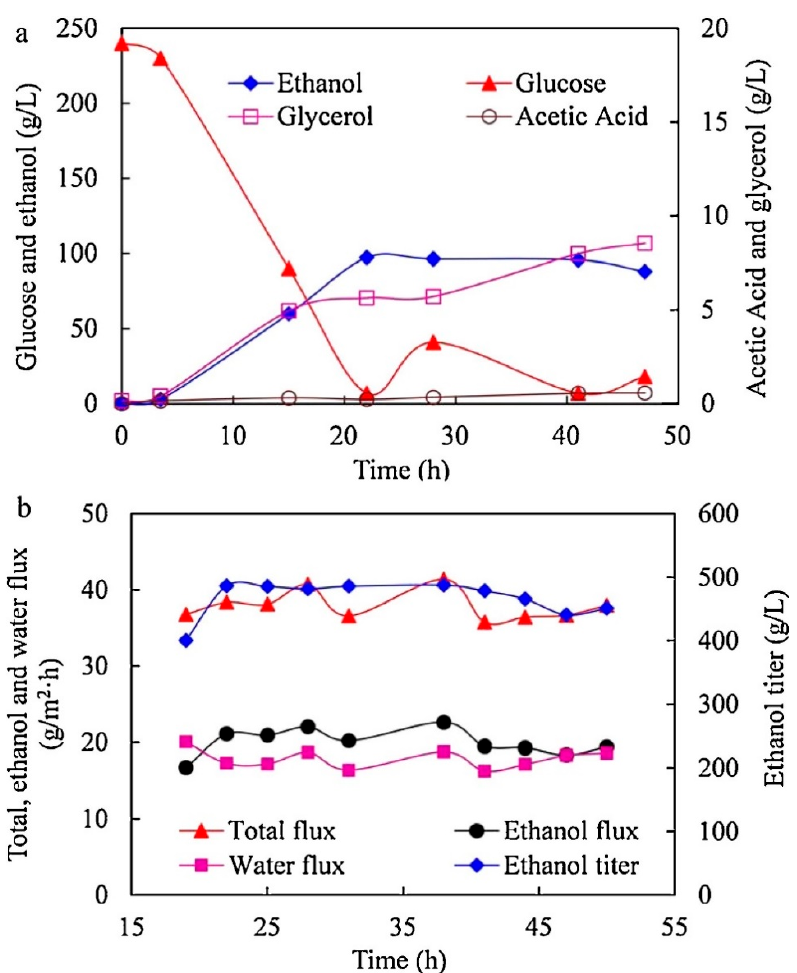
Figure 11. Ethanol fermentation based on pervaporation with a CNT-mixed PDMS membrane. ( a ) the rate at which the concentration of glucose and other products in the fermentation broth changes; ( b ) the efficiency of the pervaporation membrane during the fermentation of ethanol.